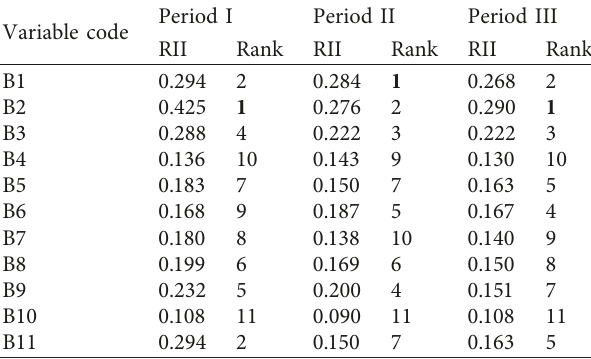
Table 12: Result of the risk importance index (RII) for labor factor. Variable code